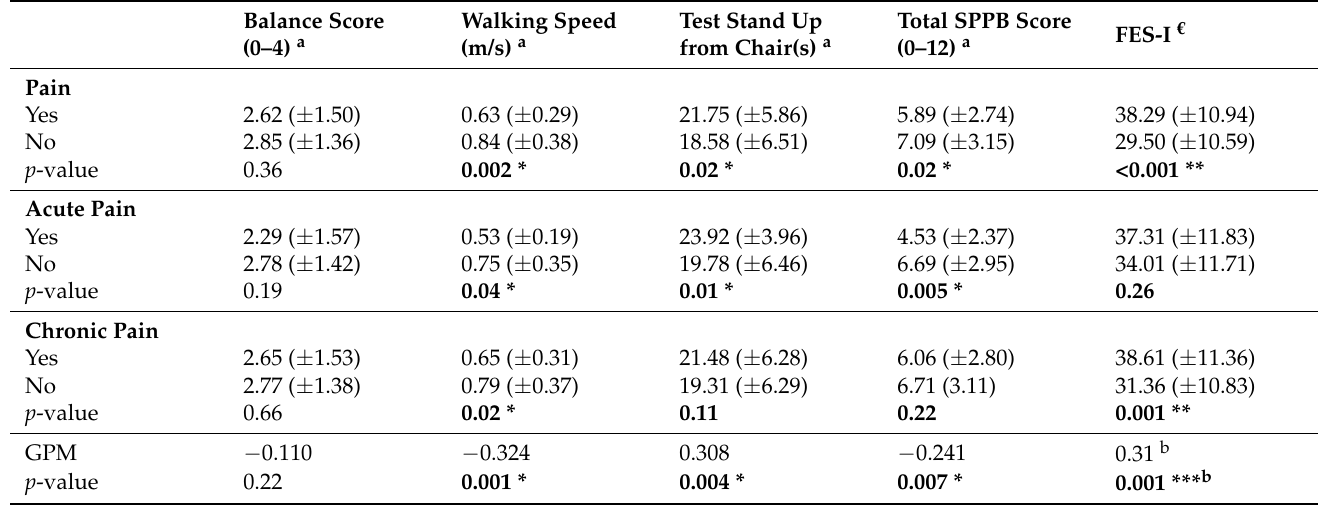
Table 3. Relationship between physical performance measures and the FES-I, according to pain characteristics, Natal, RN, 2016.